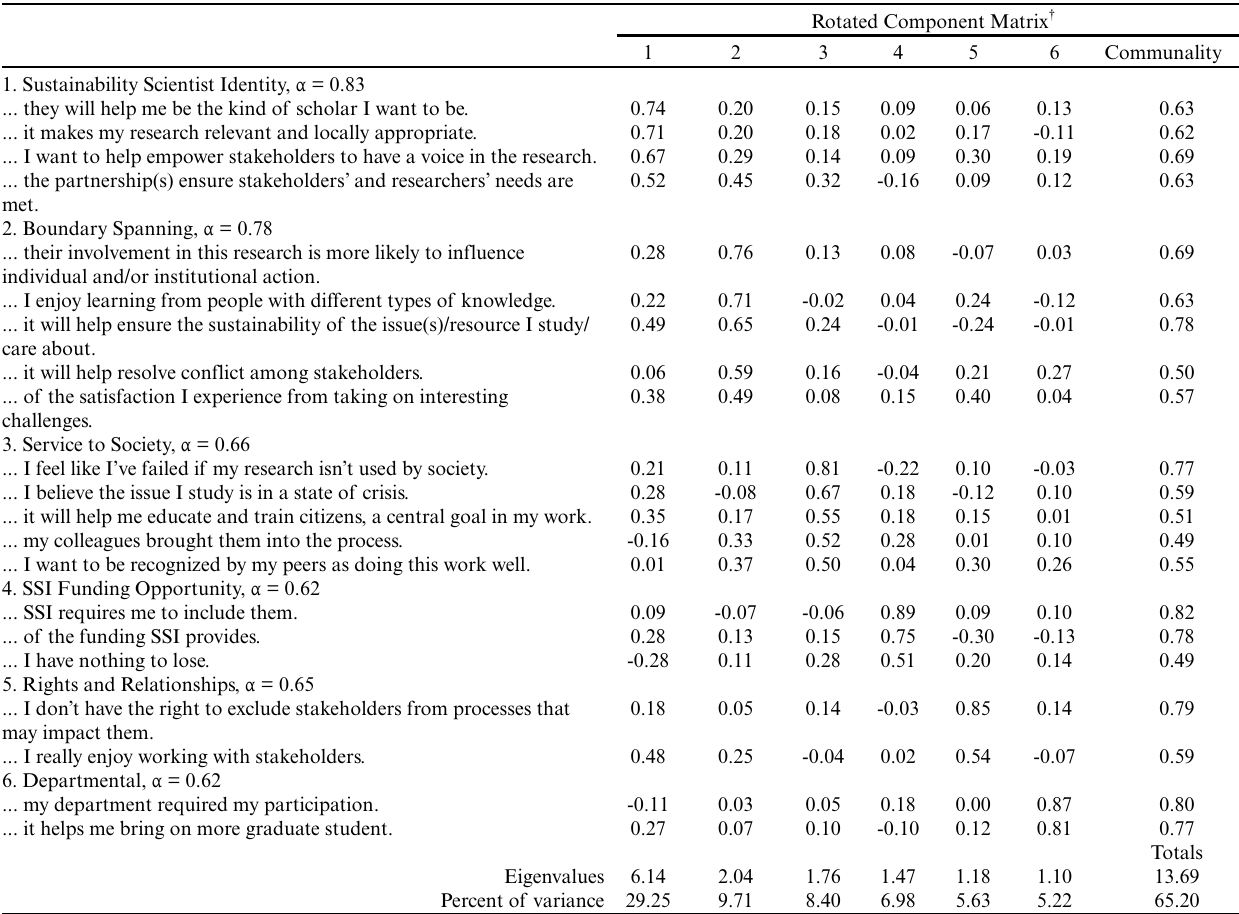
Table 4 . Principal Components Analysis (PCA) of researcher motivations for stakeholder engagement. Participants were asked to rate how much they agreed or disagreed with the following statement: “I was motivated to engage stakeholders in my SSI project(s) because